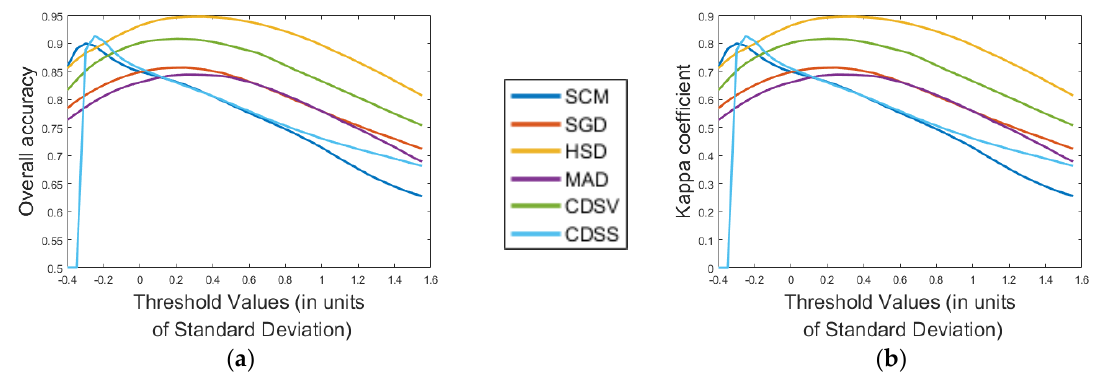
Figure 10. Accuracy assessment curves of six algorithms by different accuracy features. The x-axis pertains to the parameter 𝑚 in Equation (17) and the y-axis pertains to ( a ) overall accuracy and ( b ) kappa coefficient.